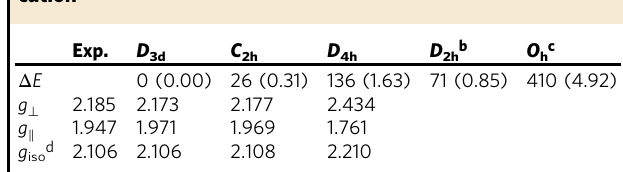
Fig. 3 Molecular structures of complexes 1 – 4 . Pale yellow colored (orange colored) crystals suitable for scXRD and with spectroscopic data in agreement with an assignment as 1 and 2 ( 3 and 4 ) were isolated from batches of reactions according to Eq. 1 (Eq. 2). However, the respective nitrogen position was never crystallographically distinguishable from the carbon positions. Therefore, only one set of molecular structures is shown: 1 and 3 (left) and 2 and 4 (right). Inclusion of a disordered nitrogen atom into the re fi nement did only slightly change the agreement factors (Supplementary Figures 70 and 72). Nevertheless, the average bond lengths are about 3 pm shorter for 3 and 4 , which agrees with the (calculated) shorter Cr – N bond length and the observed smaller unit cell volumes. Only crystallographically independent atoms were labeled; ellipsoids are shown at 50% probability level. See Table 3 for information on metric data Table 4 Calculated relative electronic energies E and g - values with different point groups for the [Cr(CO) 6 ] (cid:129) + cation